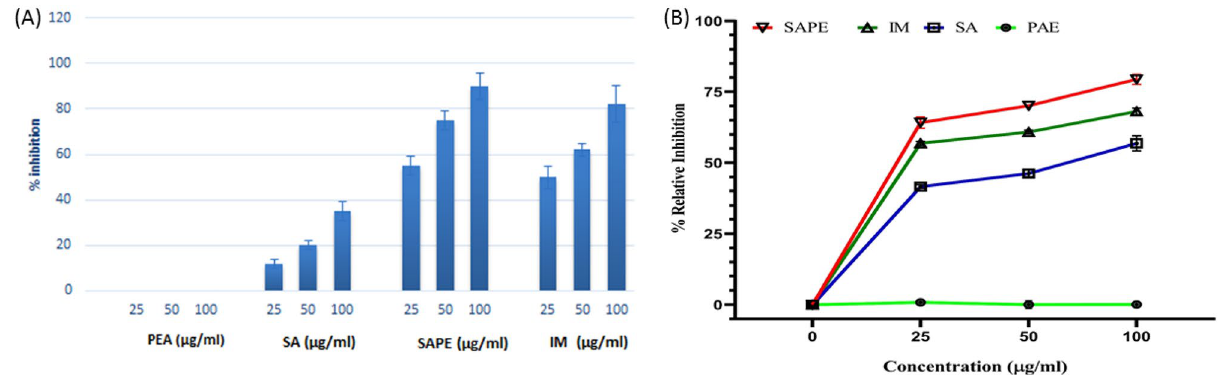
Figure 3. ( A ) The inhibition of COX-2 production in inflamed CaCo-2 cells, and ( B ) the direct relative inhibition of COX-2 by phenyl ethyl alcohol (PEA), salicylic acid (SA), salicylic acid phenyl ethyl ester (SAPE) and indomethacin